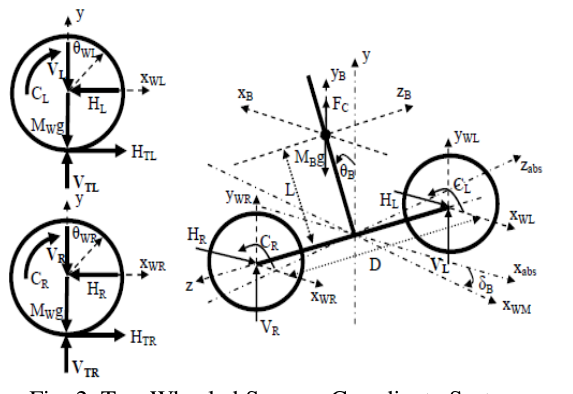
Fig. 2: Two Wheeled Segway Coordinate System Equations (1-6) are for left wheel of the Segway (same for the right